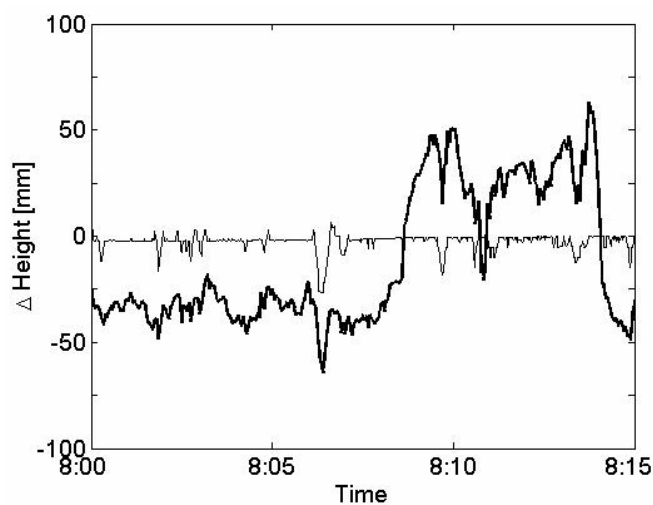
Figure 4. One of the first cases of identification of corrupted GPS signal during the monitoring of a suspension bridge in Austria excited by traffic. Thin line indicates RTS measurements and deflections of about 2 cm; bold line indicates GPS measurements with characteristic type of noise: amplification of the deflection signal, and an about 10 cm offset, due to conventional (long period) multipath because of reflections of the slowly moving satellite signal to the bridge cables.